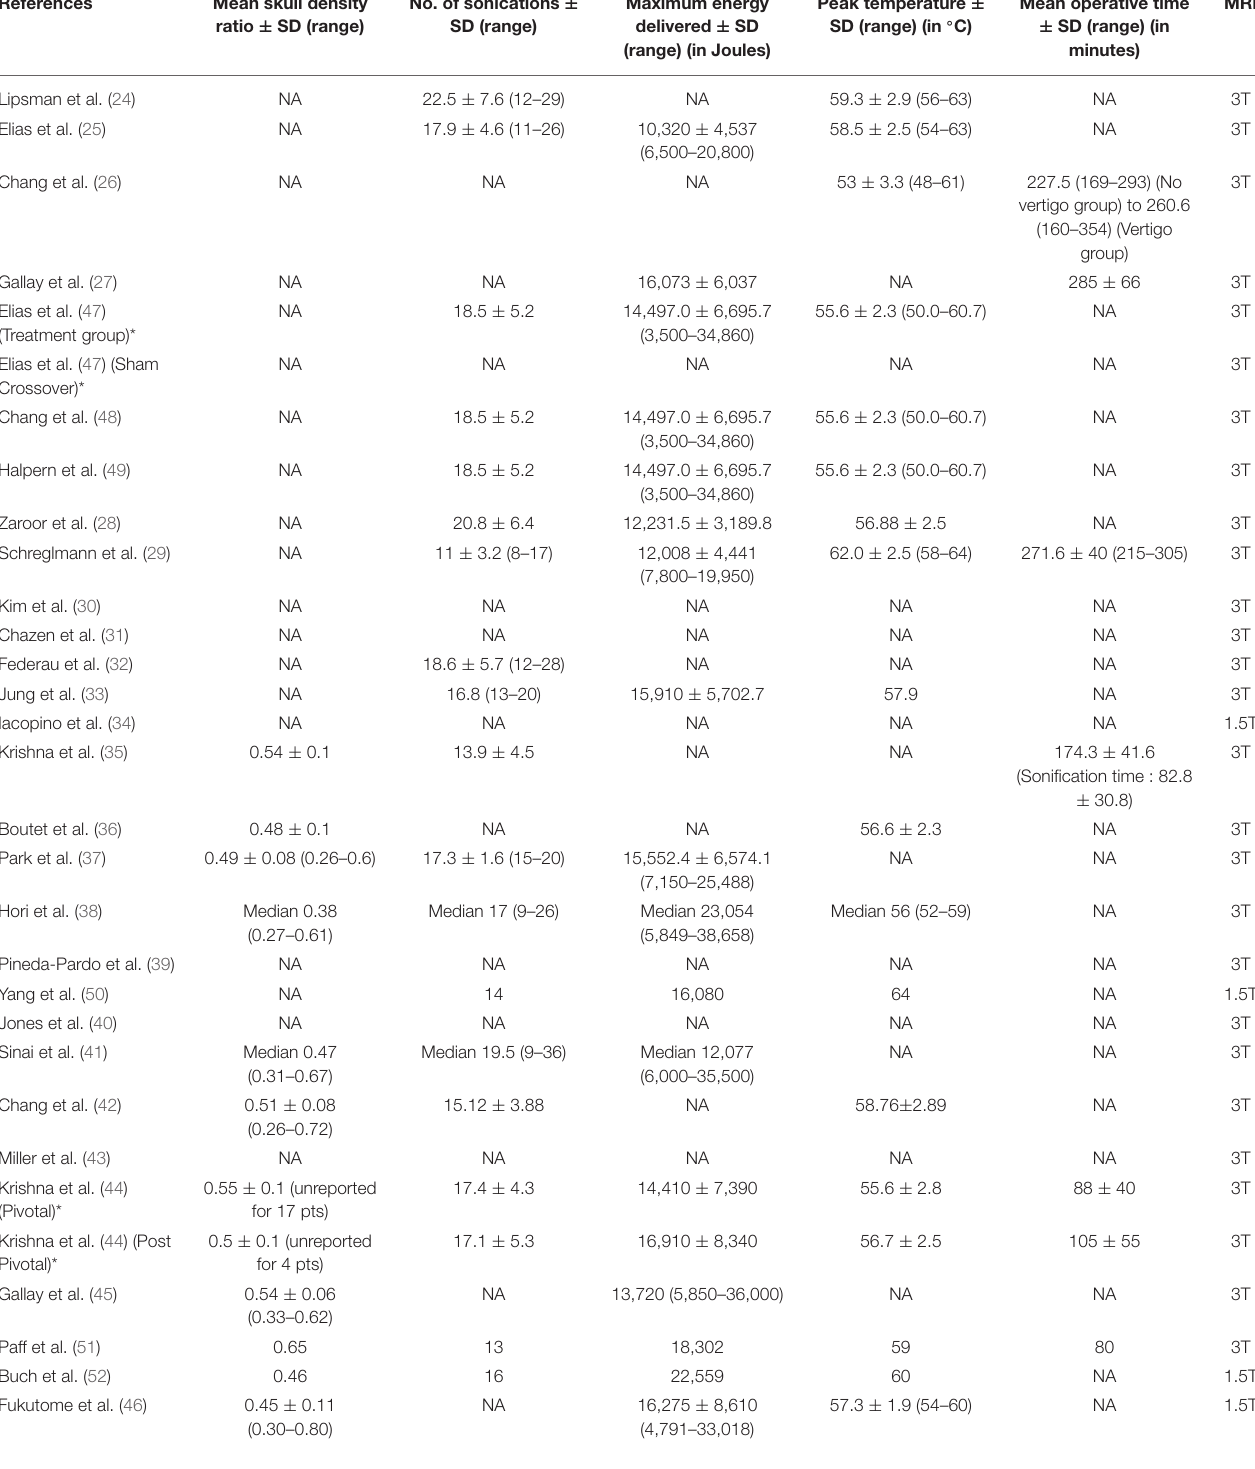
TABLE 3 | Treatment parameters [*For descriptive purposes, the cohort of patients reported by Krishna et al. (35) and Elias et al. (47) were split into two groups, each with its own distinct